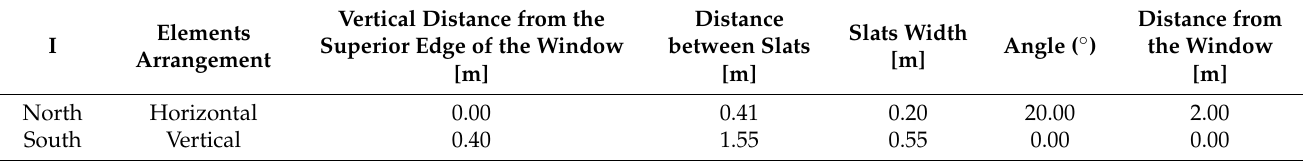
Table 8. Louvers characteristics.